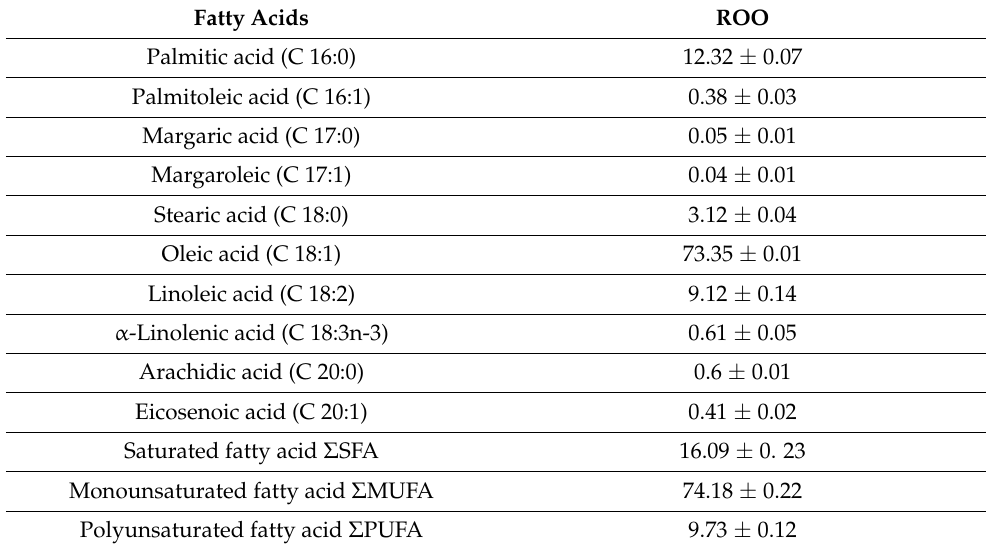
Table 1. Fatty acids composition (%) of refined olive oil (ROO).